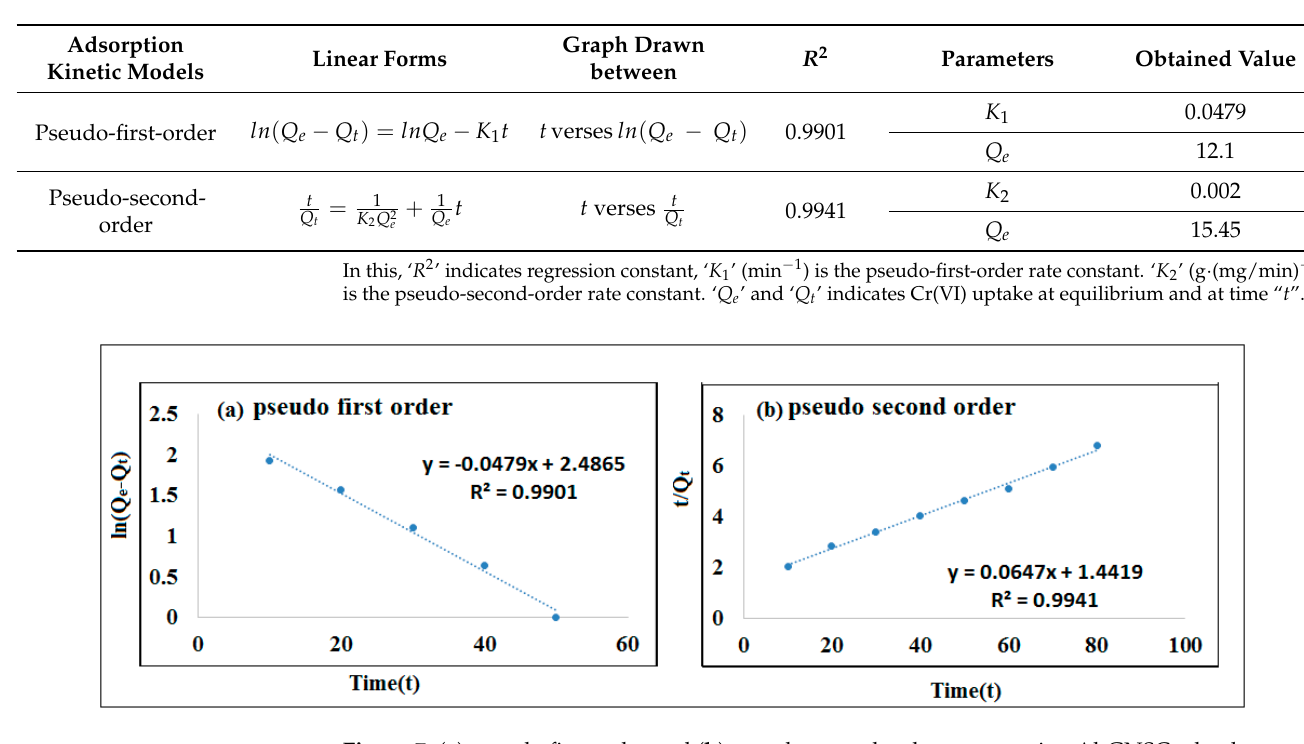
Figure 7. ( a ) pseudo first order and ( b ) pseudo second order curves using Al-GNSC adsorbent. Table 3. Pseudo first order and second order data.